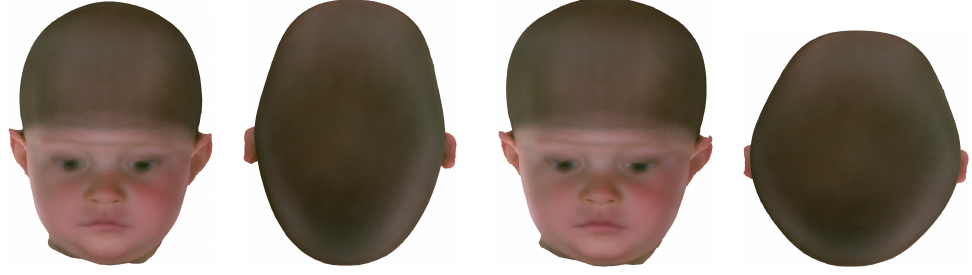
Figure 8. Patient pathology assessment using pathology change. Left: the original head shape of the scaphocephaly patient. Right: the patient’s head with removed pathology using our full SSM.